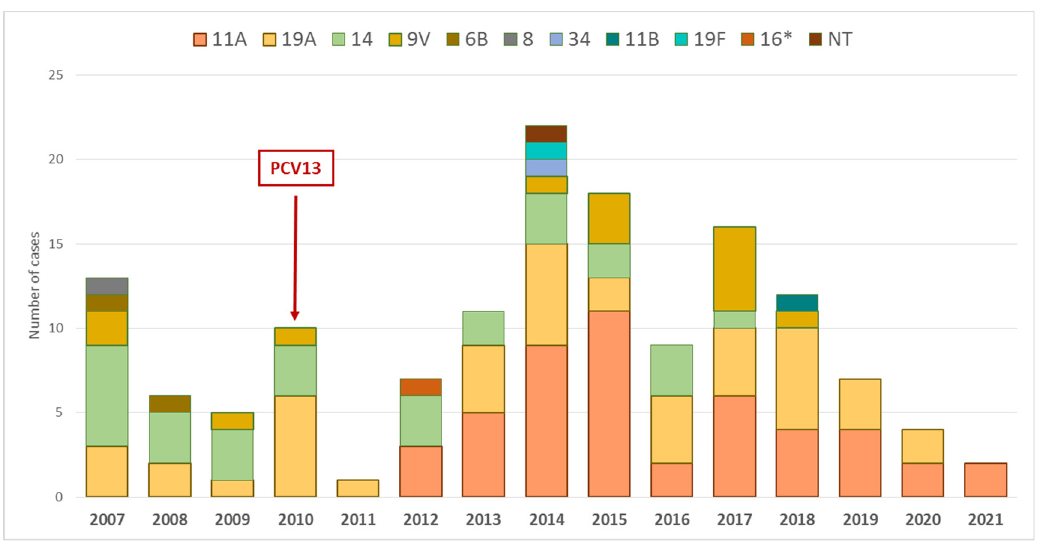
Figure 1. Evolution of the PENR serotypes across time. (Region of Madrid, 2007–2021.)